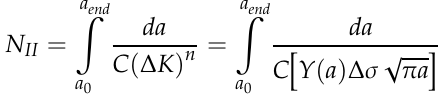
Figure 18. Numeric stress intensity factor (SIF) evaluation in mode I by the displacement correlation method.